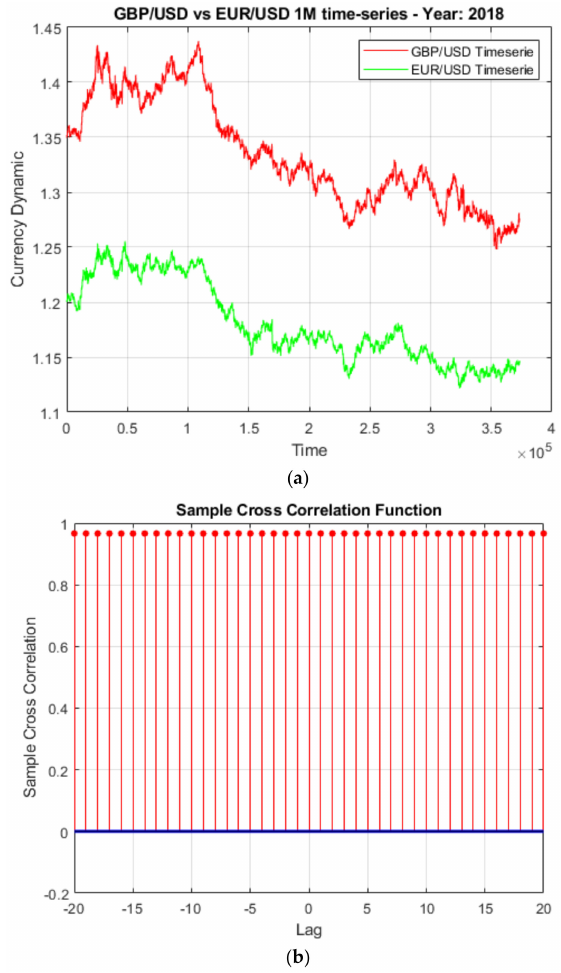
Figure 1. ( a ) The EUR / USD and GBP / USD close price time-series at 1M timeframe (year: 2018). The strong correlation between the two financial series is evident from the figure reported in ( b